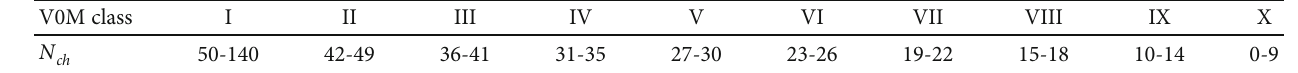
Table 1: V0 multiplicity classes and the corresponding charged particle